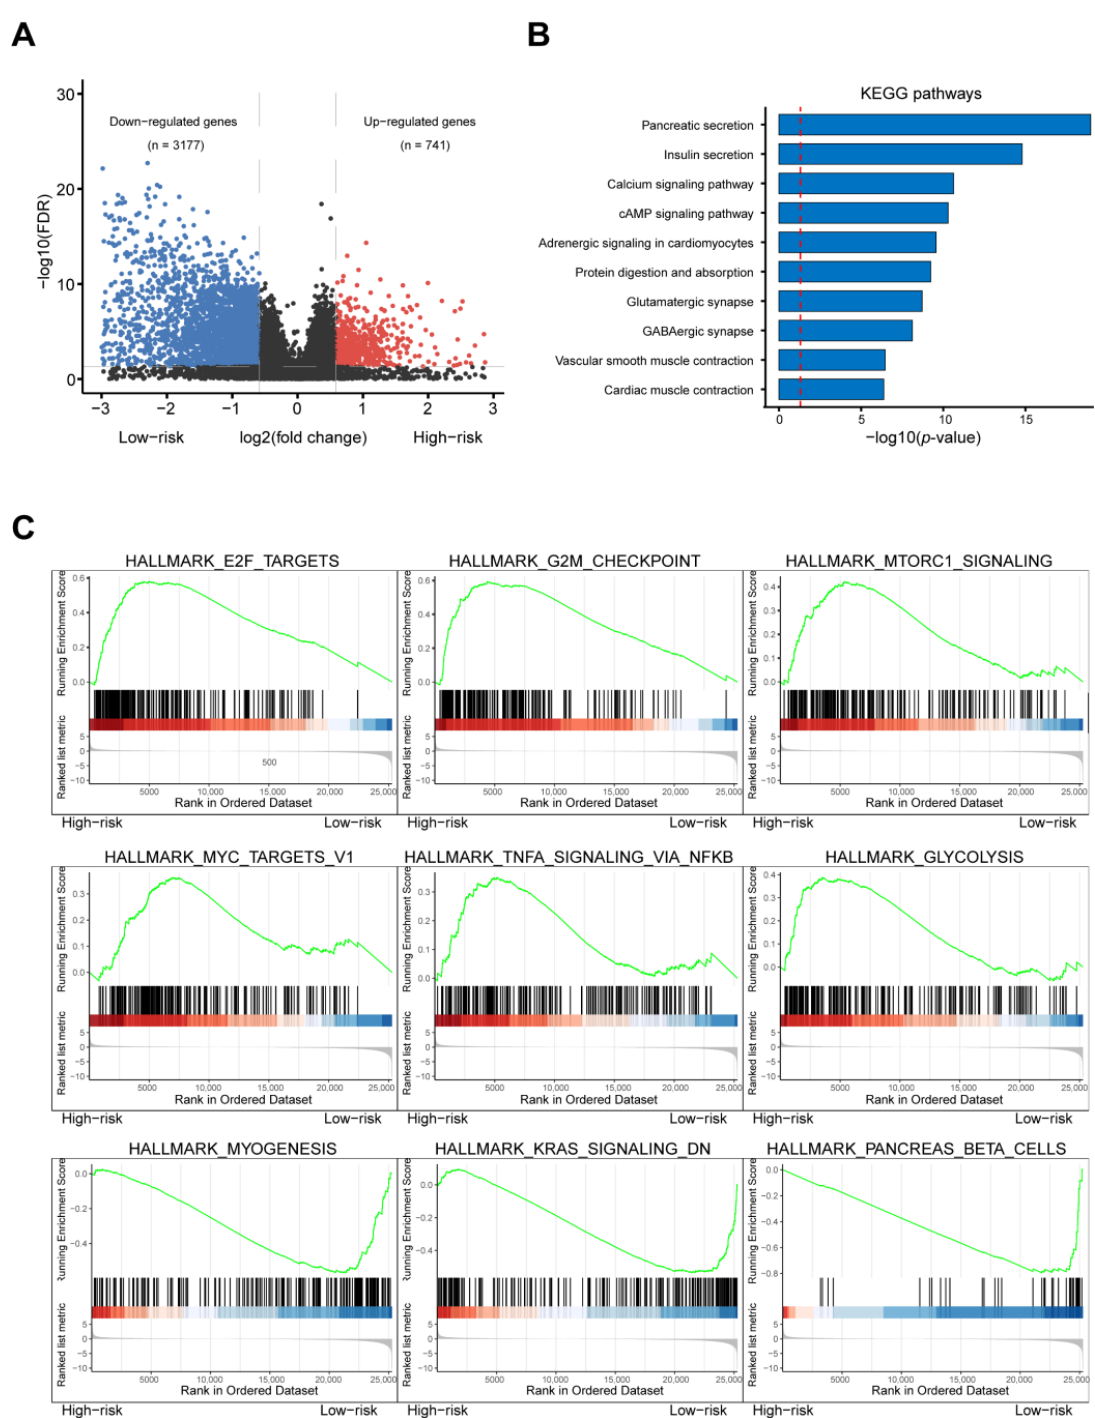
Figure 2. Transcriptomic alternation in high-risk PAAD patients. ( A ) The Volcano plot shows significant differences in gene expression between PAAD high-risk subgroups and low-risk subgroups. ( B ) Bar graphs show KEGG pathway enrichment for risk-related DEGs in PAAD patients. ( C ) Diagram of canonical gene set enrichment analysis clearly shows up- and down-regulated hallmark pathways in high-risk subgroups.